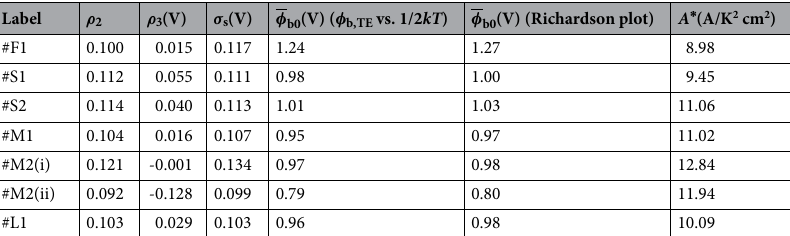
Table 1. The ρ 2 , ρ 3 , φ b0 , σ s and A ∗ values calculated from linear fits to the experimental plots of φ b,TE vs. 1 / 2 kT and 1 / n -1 vs. 1 / 2 kT and the modified Richardson plots for all contacts.